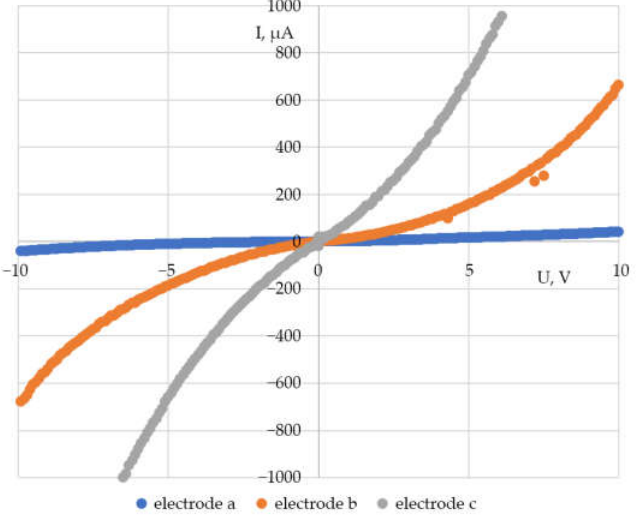
Figure 11. The current–voltage characteristics of the sample with three different electrode pressures on it: Pa < Pb < Pс.